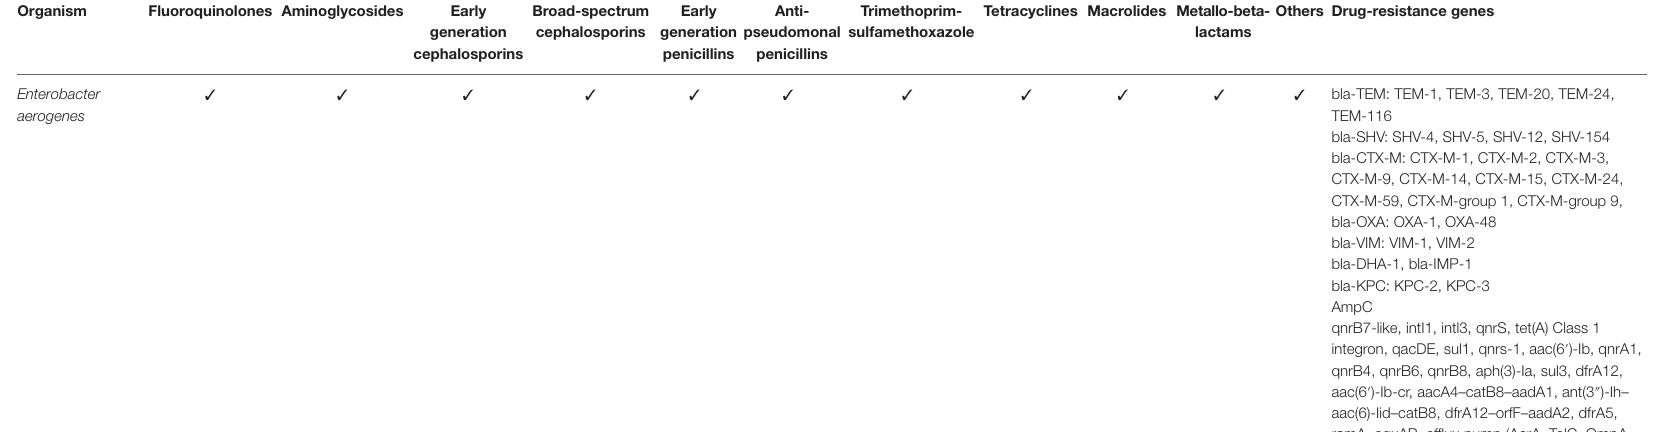
taBLe 6 | Drug-resistance and resistance genes of saprophytic Gram-negative bacteria species causing infection.